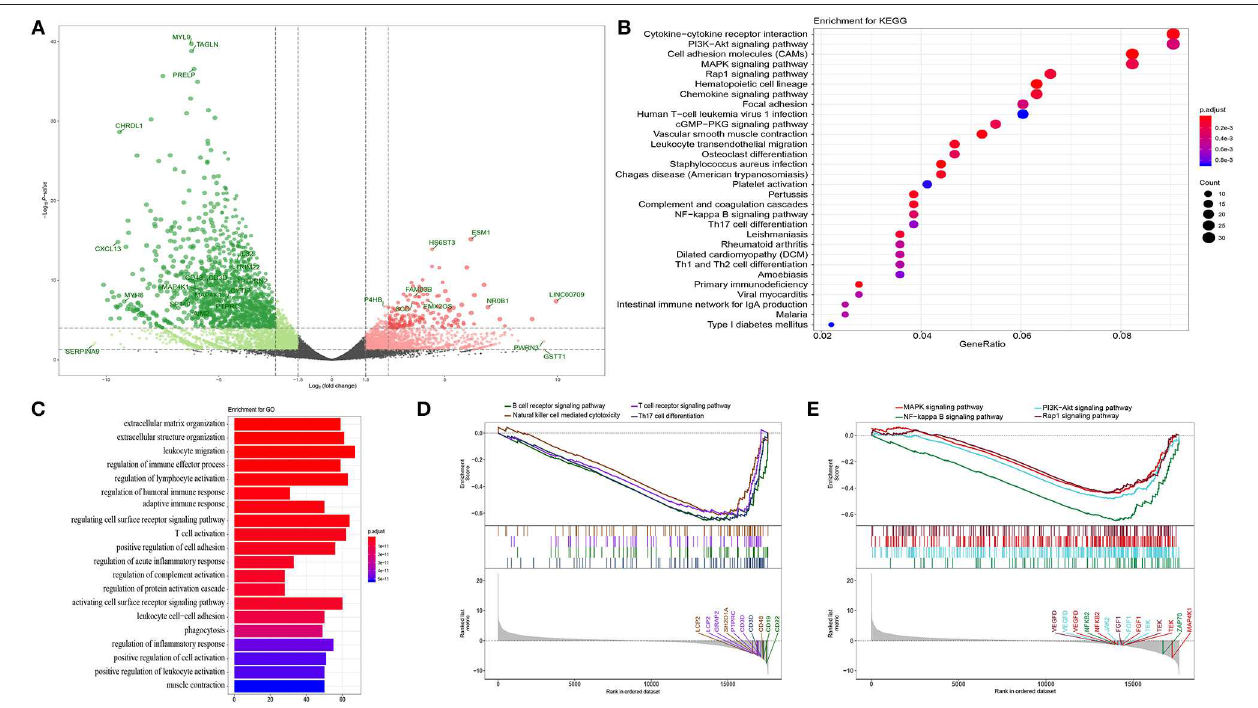
FIGURE 1 | Functional annotation. (A) Volcano plot of DEGs in bladder cancer compared with adjacent tissue. P -value were counted by the Wald test. Candidate hub genes were shown with different colors. (B) Bubble plot of top 30 enrichment of KEGG pathways. P -values were shown by different color, the size of bubble indicate the gene count of each pathway. (C) GO enrichments were arranged by top 20 significantly p values. (D,E) GSEA of whole transcription from RNA-seq, p -value was made by Kolmogorov-Smirnov